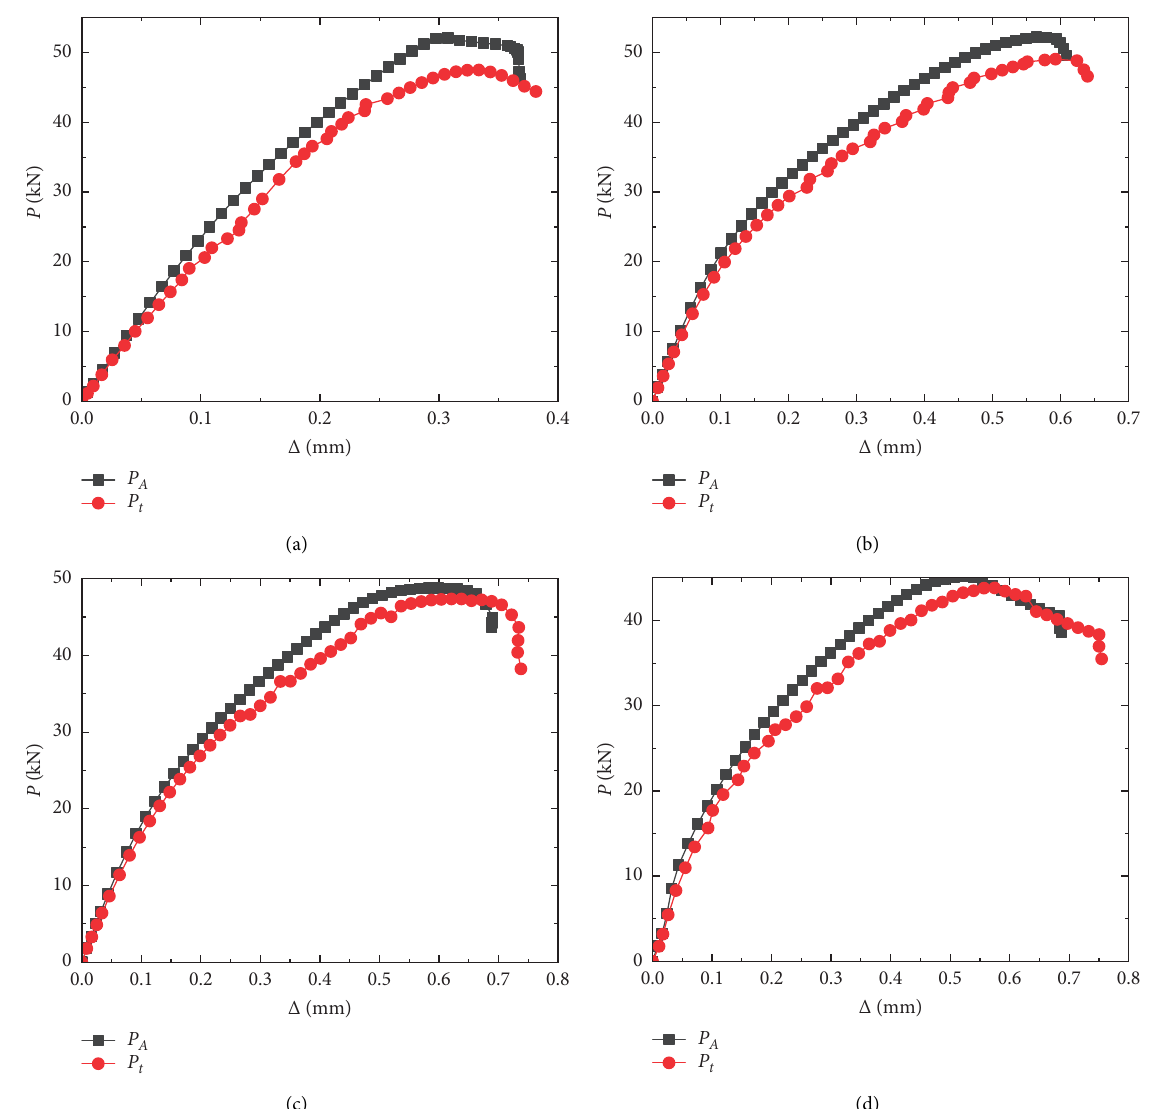
Figure 18: Comparison of load-axial displacement curves between test and FEA for section C10010 series. (a) C10010-05-NH. (b) C10010- 05-RH2. (c) C10010-05-RH4. (d)